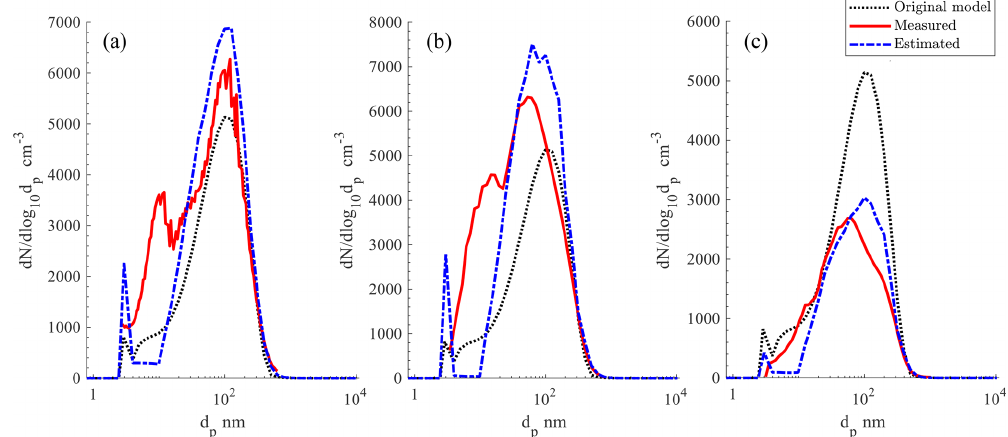
Figure 9. Average particle size distributions measured, originally predicted with a priori rates in TOMAS, and estimated with the inverse model are shown in the solid red, dotted black, and dashed blue profiles, respectively. Results are shown using measurements at (a) San Pietro Capofiume, (b) Melpitz, and (c)